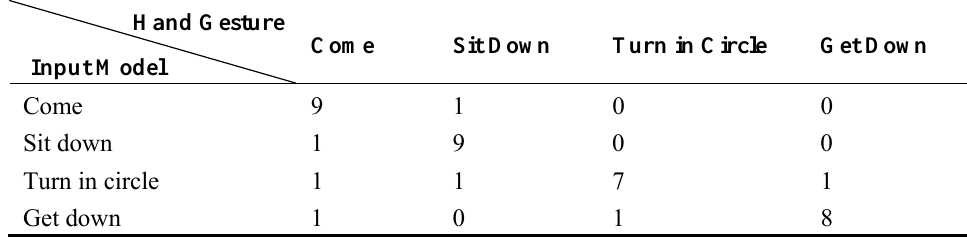
Table 5. Confusion matrix for recognition results of dynamic hand gestures with a Kalman